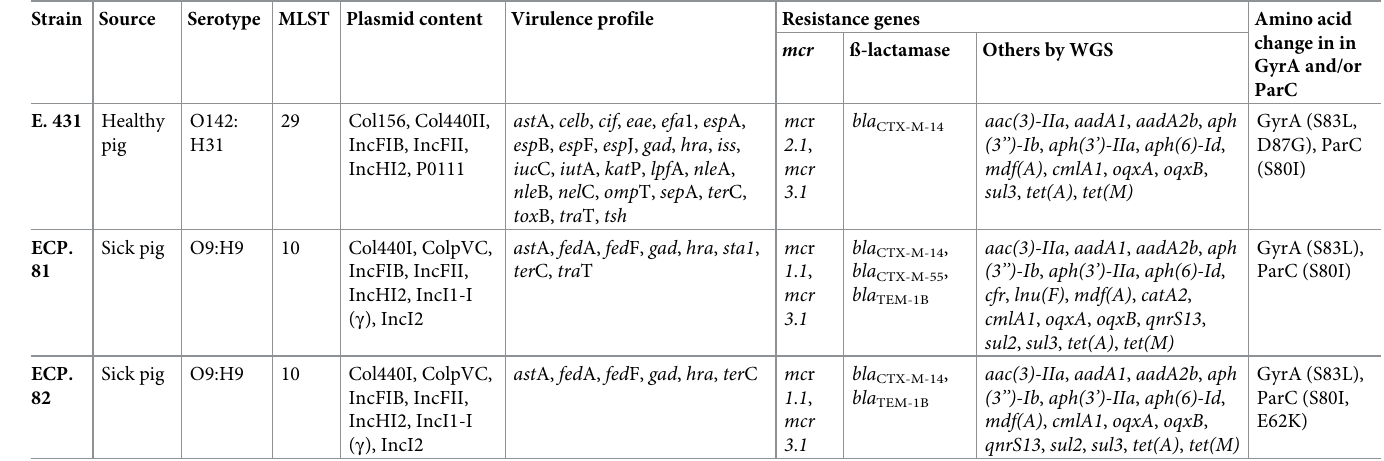
Table 2. Molecular characteristics of ESBL-producing E . coli carrying mcr from pigs in Thailand (n = 3). Strain